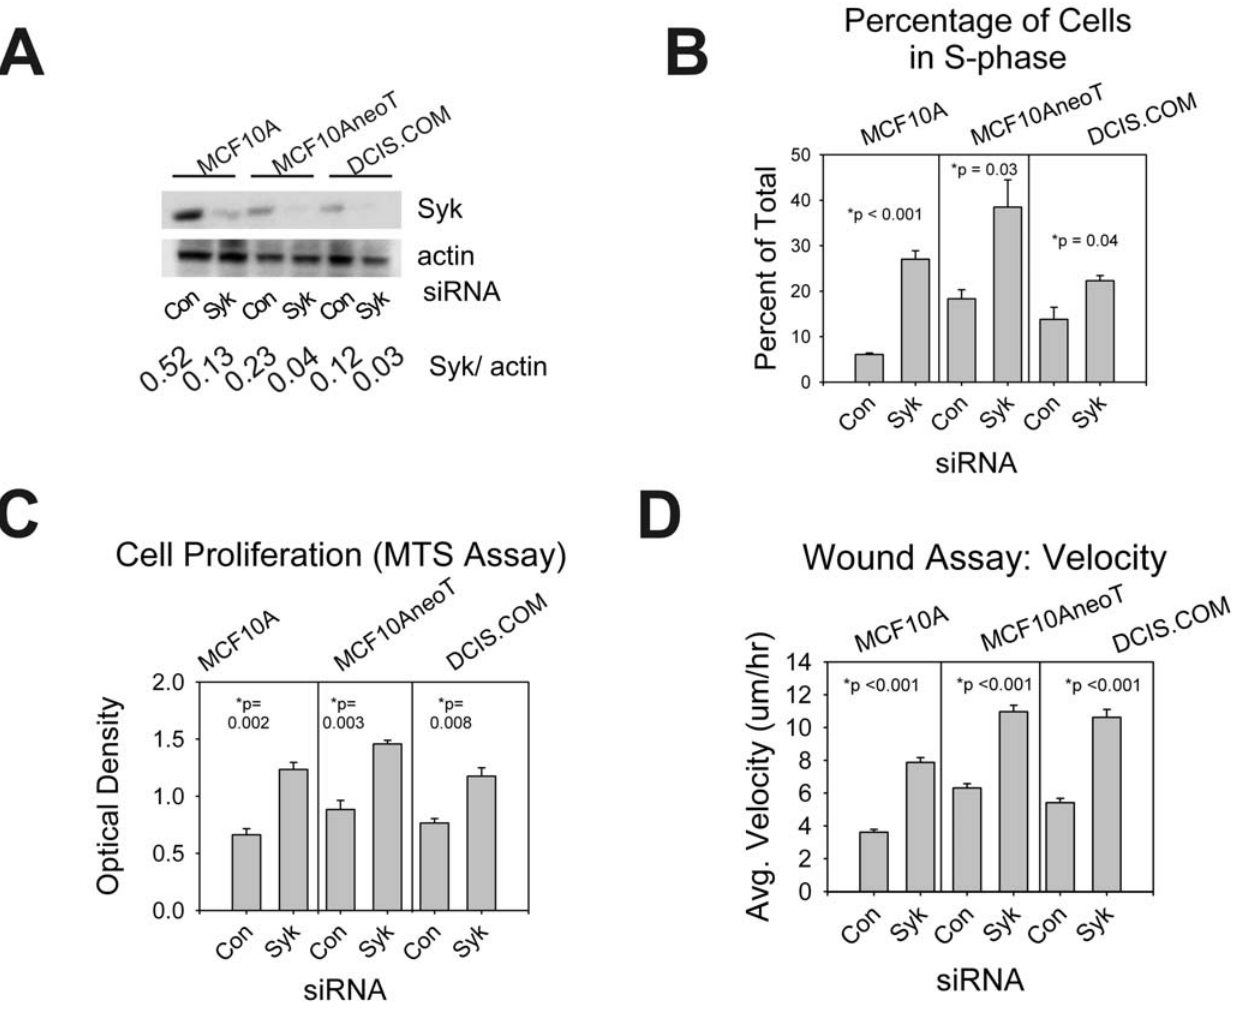
Figure 1. Cell proliferation and migration of MCF10A, MCF10AneoT, and DCIS.com human mammary epithelial cells. (A) Decreases in Syk protein levels are shown for control versus Syk siRNA transfection of normal MCF10A cells and tumorigenic MCF10AneoT and DCIS.com cells. Increased cell proliferation (B) and cell growth (C) was observed following Syk knockdown. (D) Increased velocity of MCF10A, MCF10AneoT, and DCIS.com cell migration was observed in Syk knockdown cells using a scratch/wound assay. (B–D) Data is represented as means + / 2 SEM. P values are significant by the student’s t-test for all cell lines, average of 3 independent experiments.